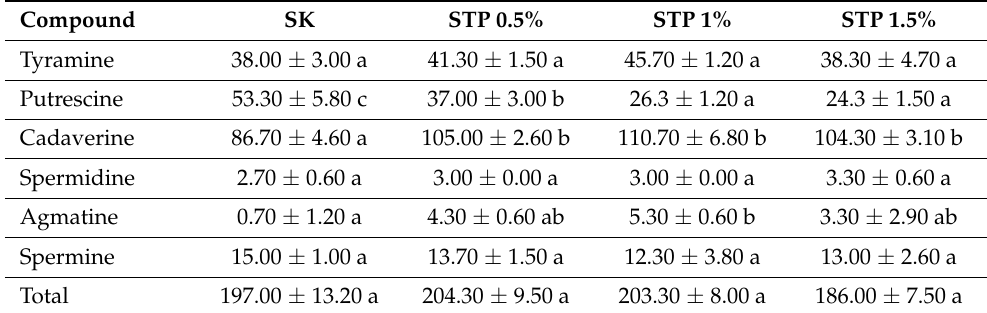
Table 7. The biogenic amines of dry fermented sausages [mg kg − 1 ].